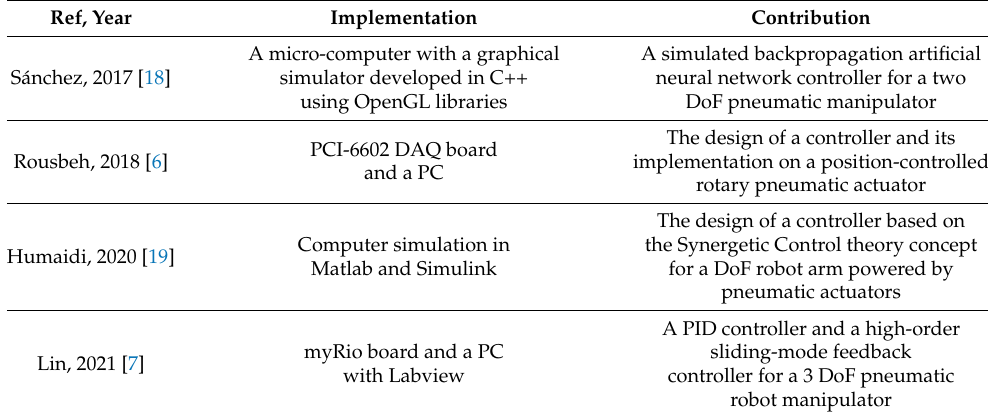
Table 1. State of the